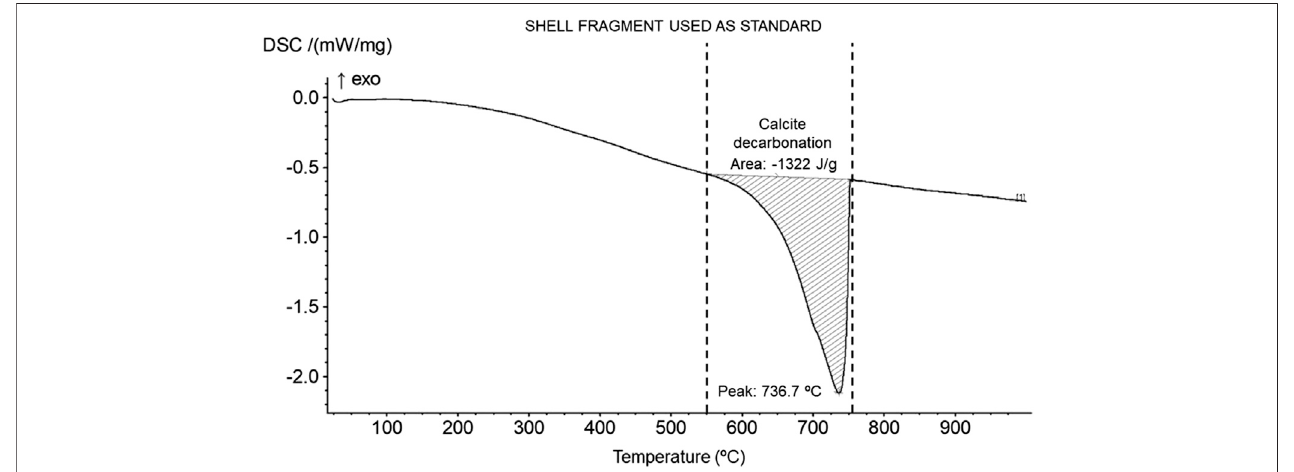
FIGURE 8 | DSC of shell fragment used as standard for binder content